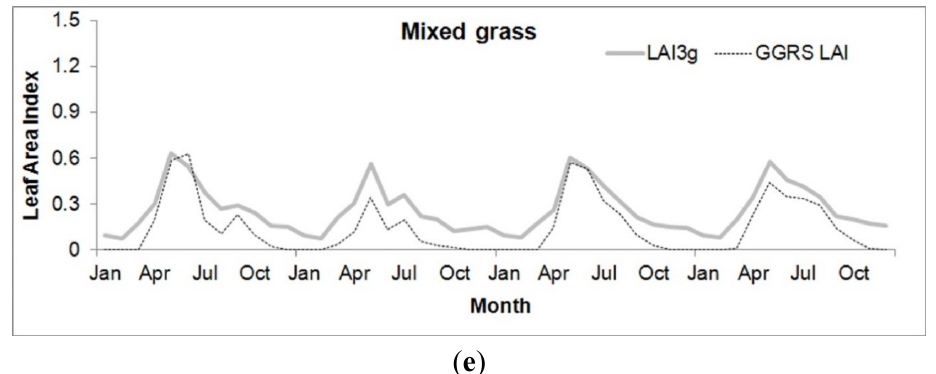
Figure 9. Seasonal trajectories of LAI3g and LAI GGRS for test sites in forest ( a , b ); reed grass ( c ); short grass ( d ); and mixed grass ( e ) during the period